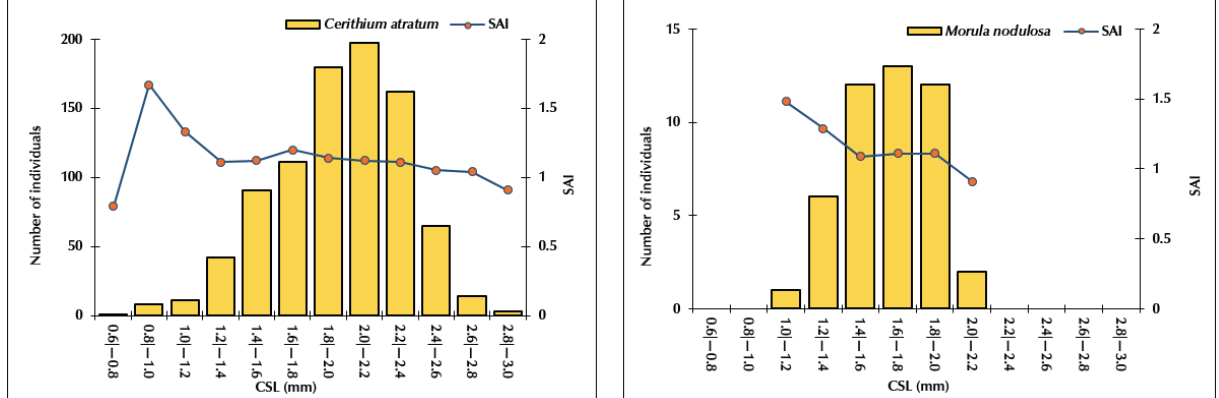
Figure 3. Pagurus criniticornis . Variation of the shell adequacy index (SAI) values for each most occupied shell species in relation to the size classes. (Data are expressed as mean ± SD).